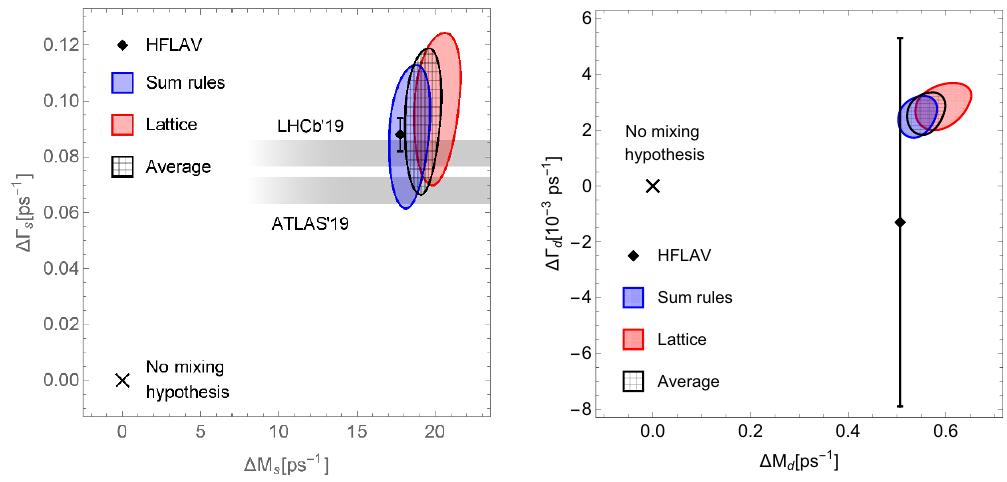
B q and the FNAL/MILC’16 [12] results for Q 1 B q